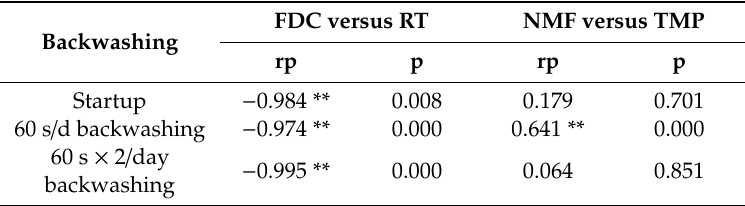
Table 3. Pearson Correlation analysis for FDC versus TMP and normalized membrane flux (NMF) versus TMP.